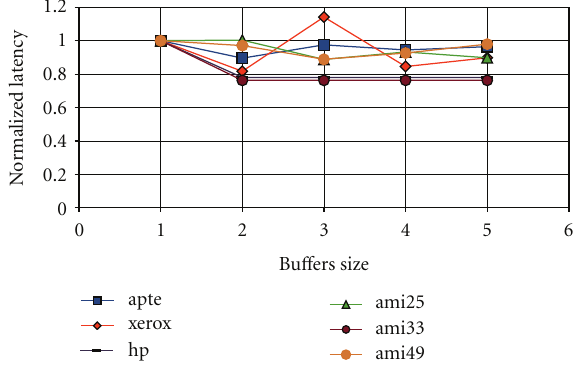
Figure 15: Normalized latency with variation of the bu ff ers size for the packet injection rate when the network saturation occurs.